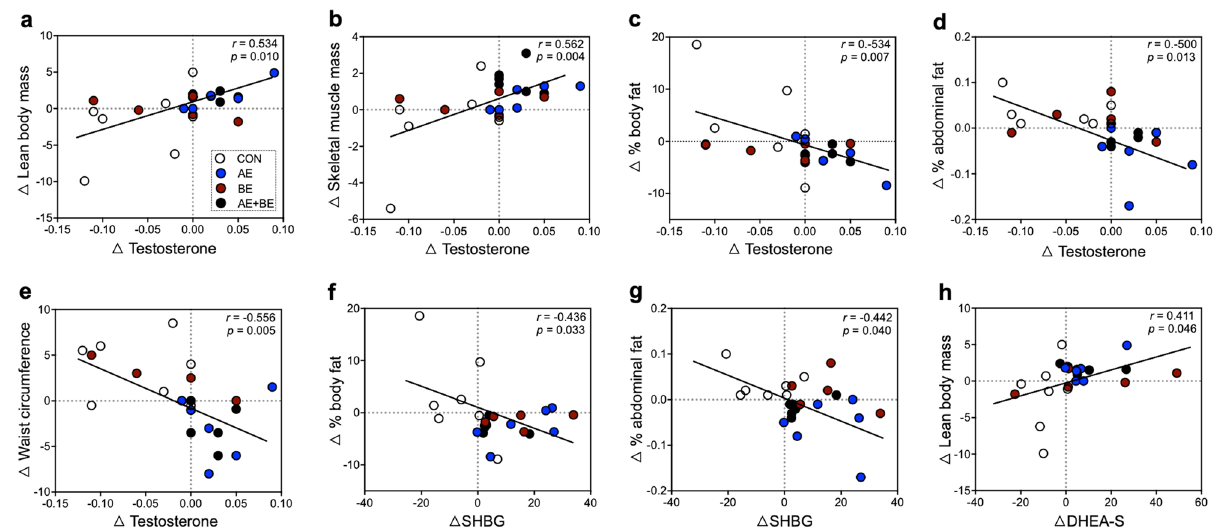
Figure 3. Correlation between body composition indices and sex hormones. ( a – e ) Δ-testosterone was correlated with Δ-lean body mass, Δ-skeletal muscle mass, Δ-percentage of body fat, Δ-percentage of abdominal fat and, Δ-waist circumference. ( f , g ) Δ-SHBG (sex hormone-binding globulin) was correlated with Δ-percentage of body fat and Δ-percentage of abdominal fat. ( h ) A significant correlation was observed between Δ-DHEA-S (dehydroepiandrosterone sulfate) and Δ-lean body mass. Correlation analysis was performed (Pearson’s correlation coefficients). Each circle represents an individual subject ( n =